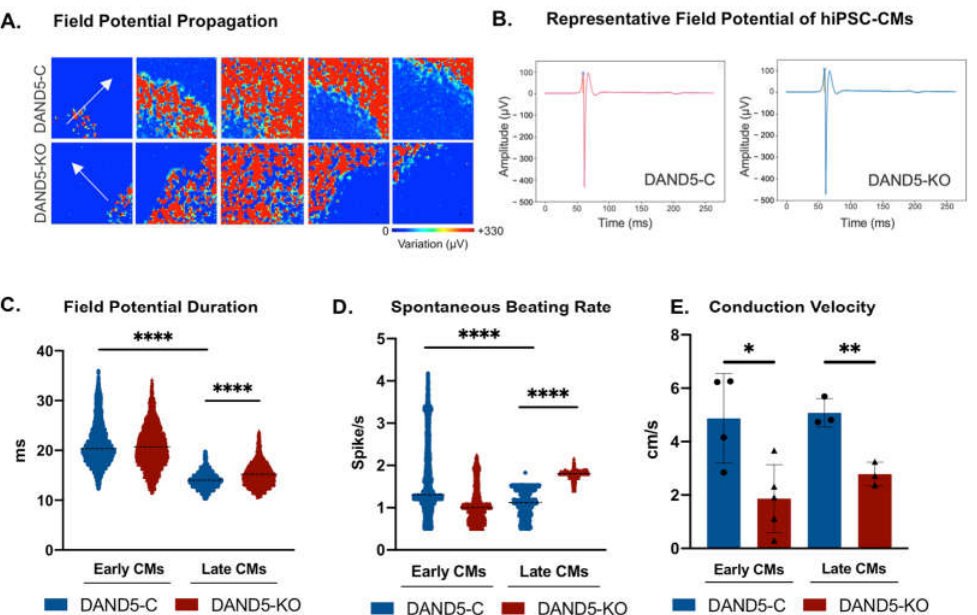
Figure 4. Electrophysiological analysis of DAND5 hiPSC-CMs using MEA. ( A ) Snapshots of MEA recordings show spontaneous FP, which propagates across a monolayer of DAND5-C (top panel) and DAND5-KO (bottom panel) cells. The white arrow denotes the direction of FP propagation. FPs were recorded with a high-pass filter of 50 Hz for 2 min. ( B ) Mean waveform of FP of the DAND5-C (pink) and DAND5-KO (blue) lines. The mean waveform was obtained by selecting active electrodes displaying a variation higher than 330 µ Volts using BrainWave 4 Software and in house Python script. ( C ) Field potential duration. ( D ) Spontaneous beating rate. ( E ) Conduction velocity. Data represented the scatter plot of all individual values of four independent biological experi- ments. Unpaired Student’s t-test was applied to compare the differences between the DAND5-C and DAND5-KO groups on each day of differentiation. Statistically significant results were consid- ered when * p < 0.05, ** p < 0.01, and **** p < 0.0001.